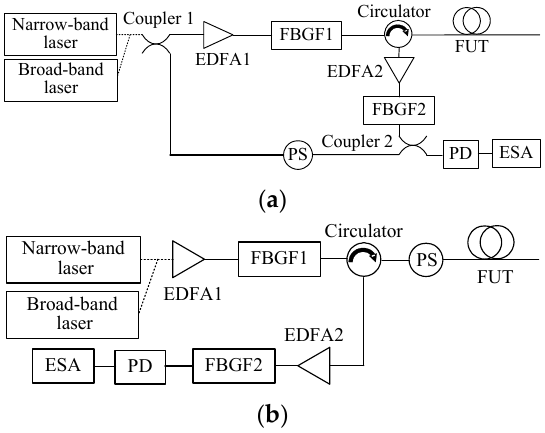
Figure 2. Experimental setups for Brillouin spectrum measurement employing narrow-band and broad-band lasers based on ( a ) local heterodyne detection and ( b ) self-heterodyne detection.